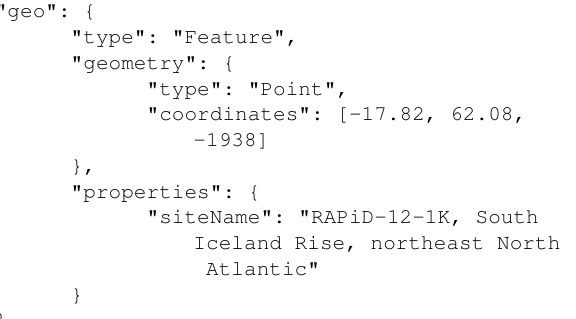
The GeoJSON standard defaults to the WGS84 ellipsoid, and units of decimal degrees for latitude and longitude and meters above sea level for elevation. This standard readily accommodates polygonal and multipoint geographic features and additional location metadata that allow for a much richer suite of geographic metadata than are typically recorded with paleoclimate data